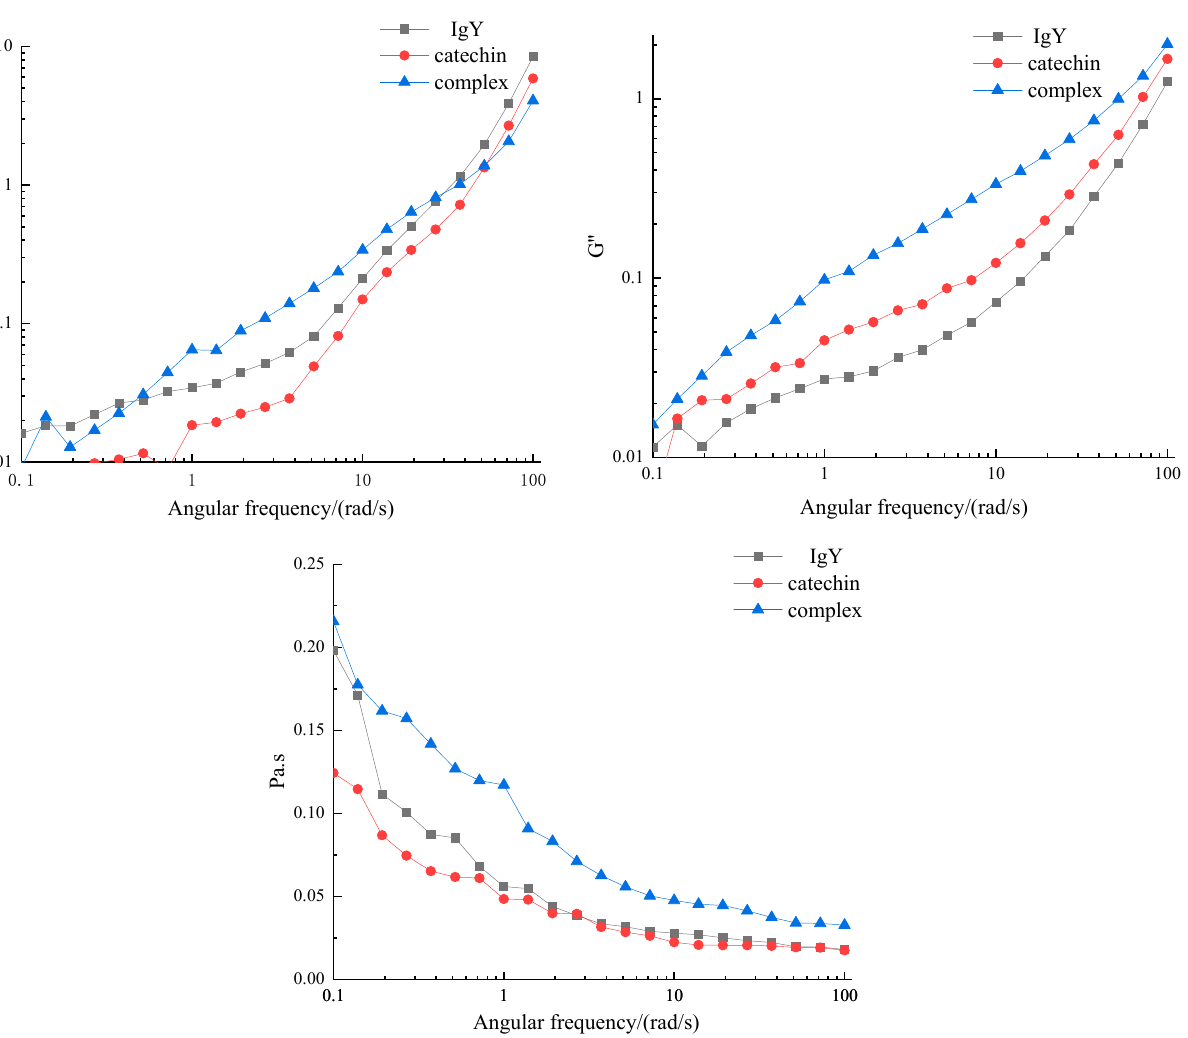
Figure 8. Effect of IgY interactions with catechins on rheological properties.